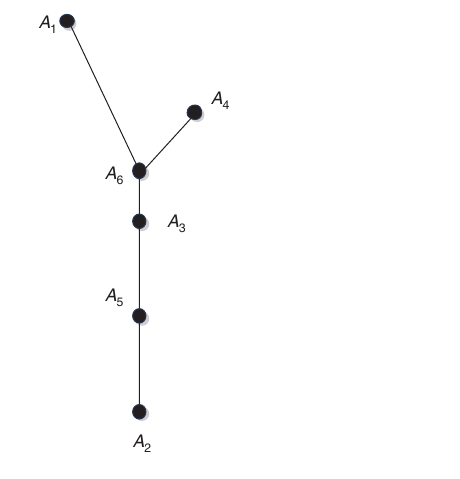
Figure 8. The MST of the Intuitionistic Fuzzy Graph G = ( V , E ).